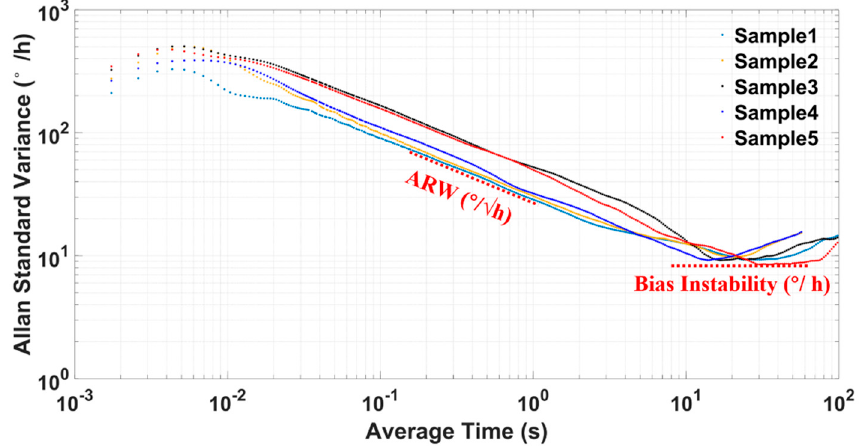
Figure 13. The Allan standard variance analysis results for typical TFGs.